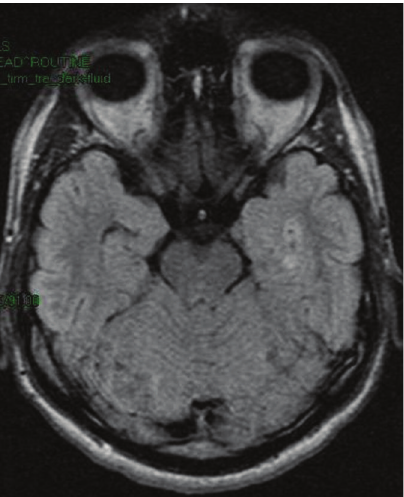
Figure 4: Neurocysticercosis. Round-ovalar, hyperintense, tempo- ral lesions on FLAIR MRI sequence, suggesting “cyst with a dot” appearance. Department of Neurology, Colentina Clinical Hospital brain imaging